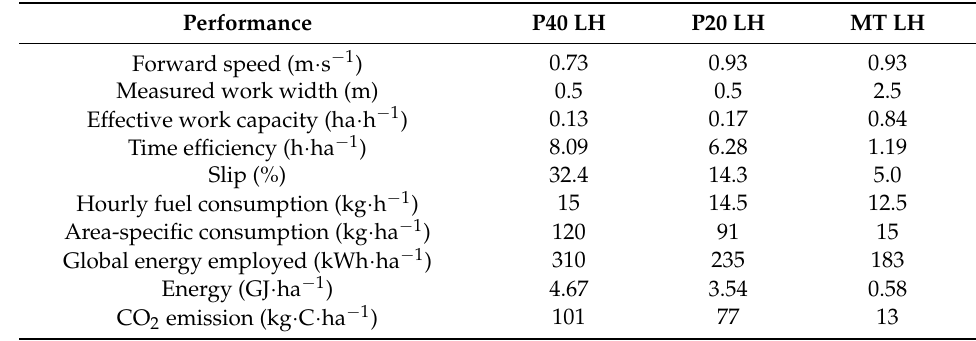
Table 4. Performance of tracked and wheeled tractors during soil tillage carried out at low soil water content low humidity (LH) (58%